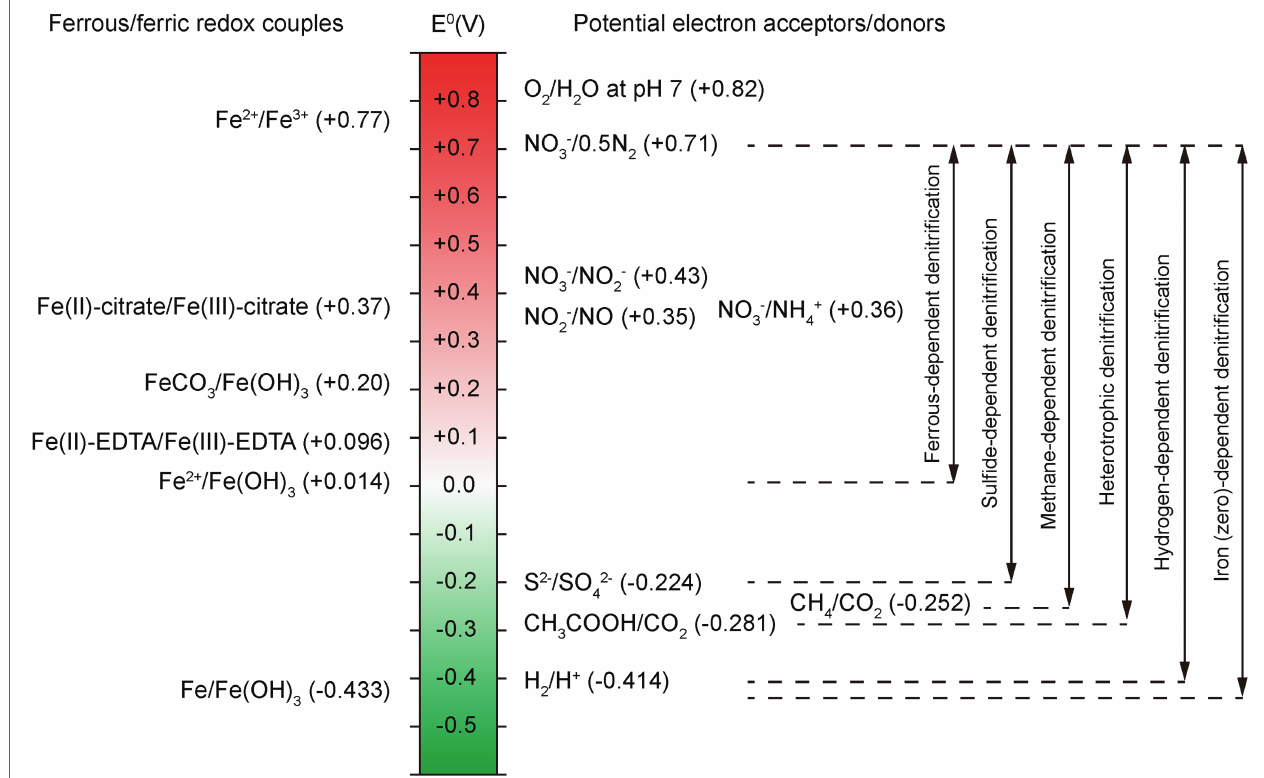
FIGURE 4 | Redox potential of Fe and N species couples in NDAFO; the double-headed arrows refer to the Δ ORP between different denitrification processes (Hedrich et al.,